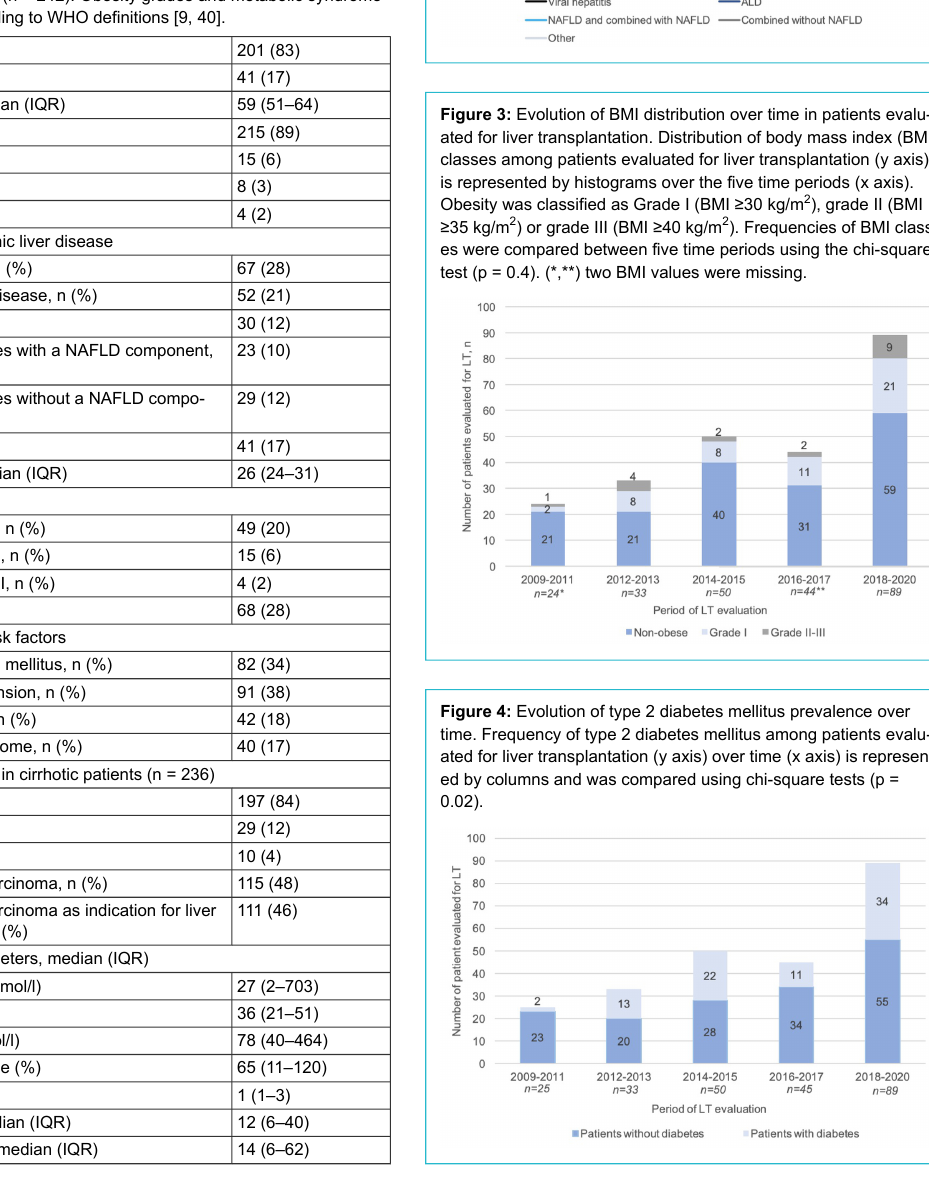
Table 1: Demographic and clinical characteristics of patients at liver transplan-